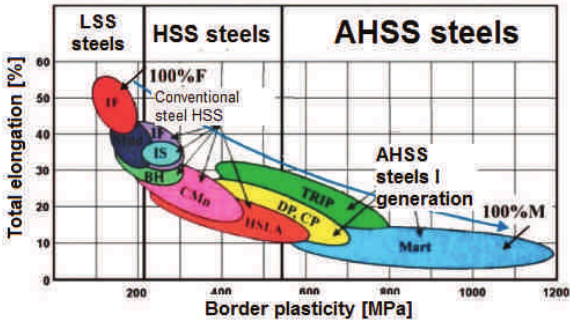
Fig. 3. Comparison of the mechanical properties of conventional HSS steels and modern AHSS steels used in transport